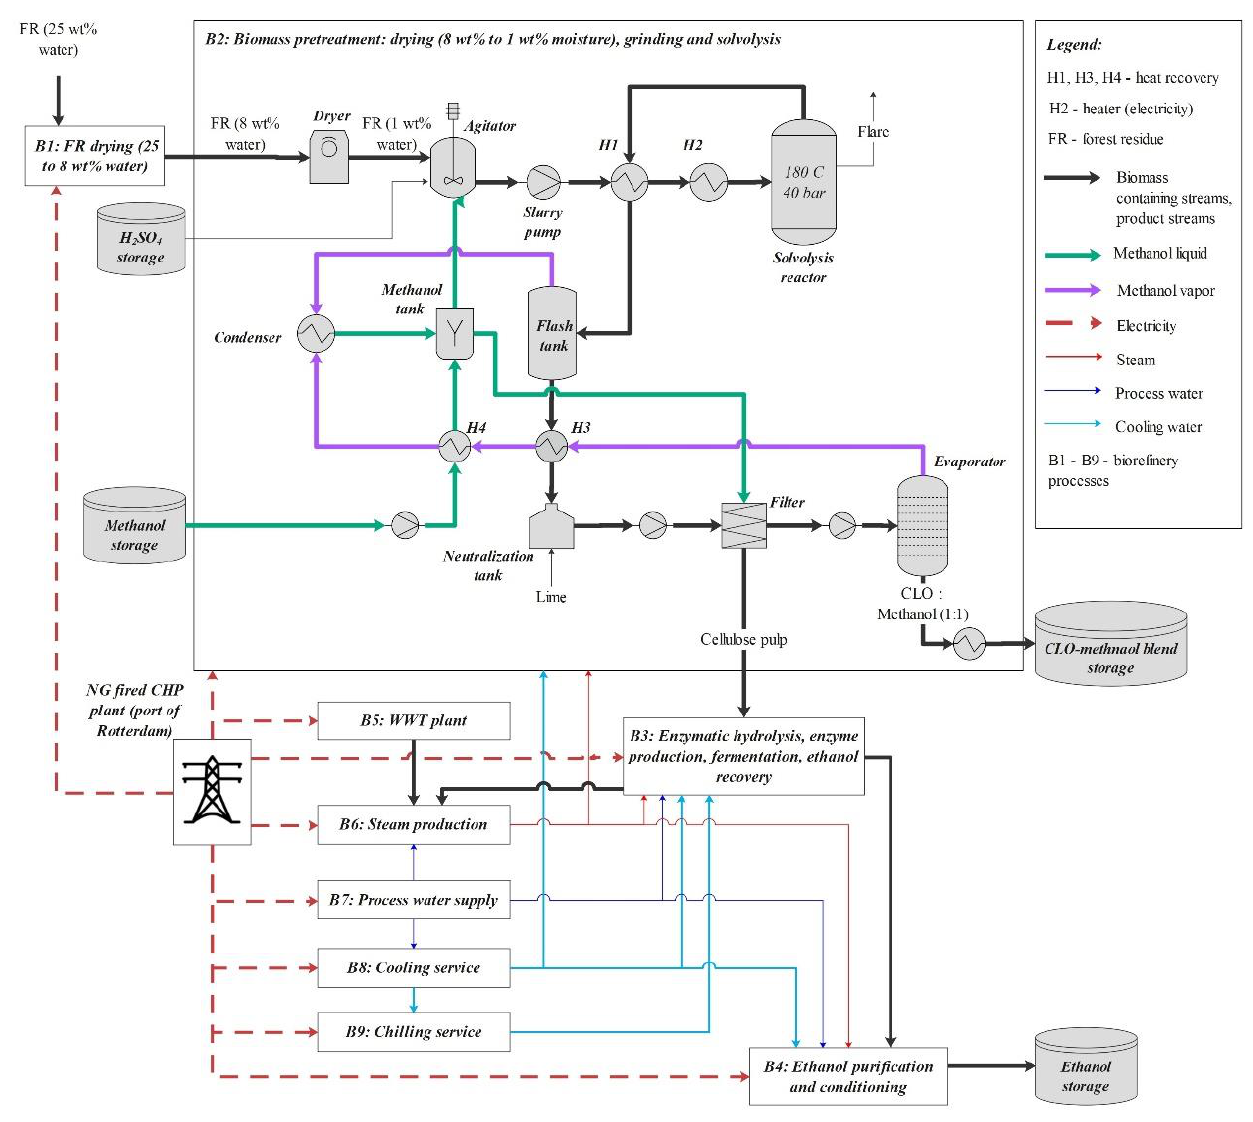
Figure 1. Biomass pretreatment process — principal flow diagram and its integration into cellulosic ethanol biorefinery. Table 1. Biorefinery inventory for the production of 1 t of CLO.